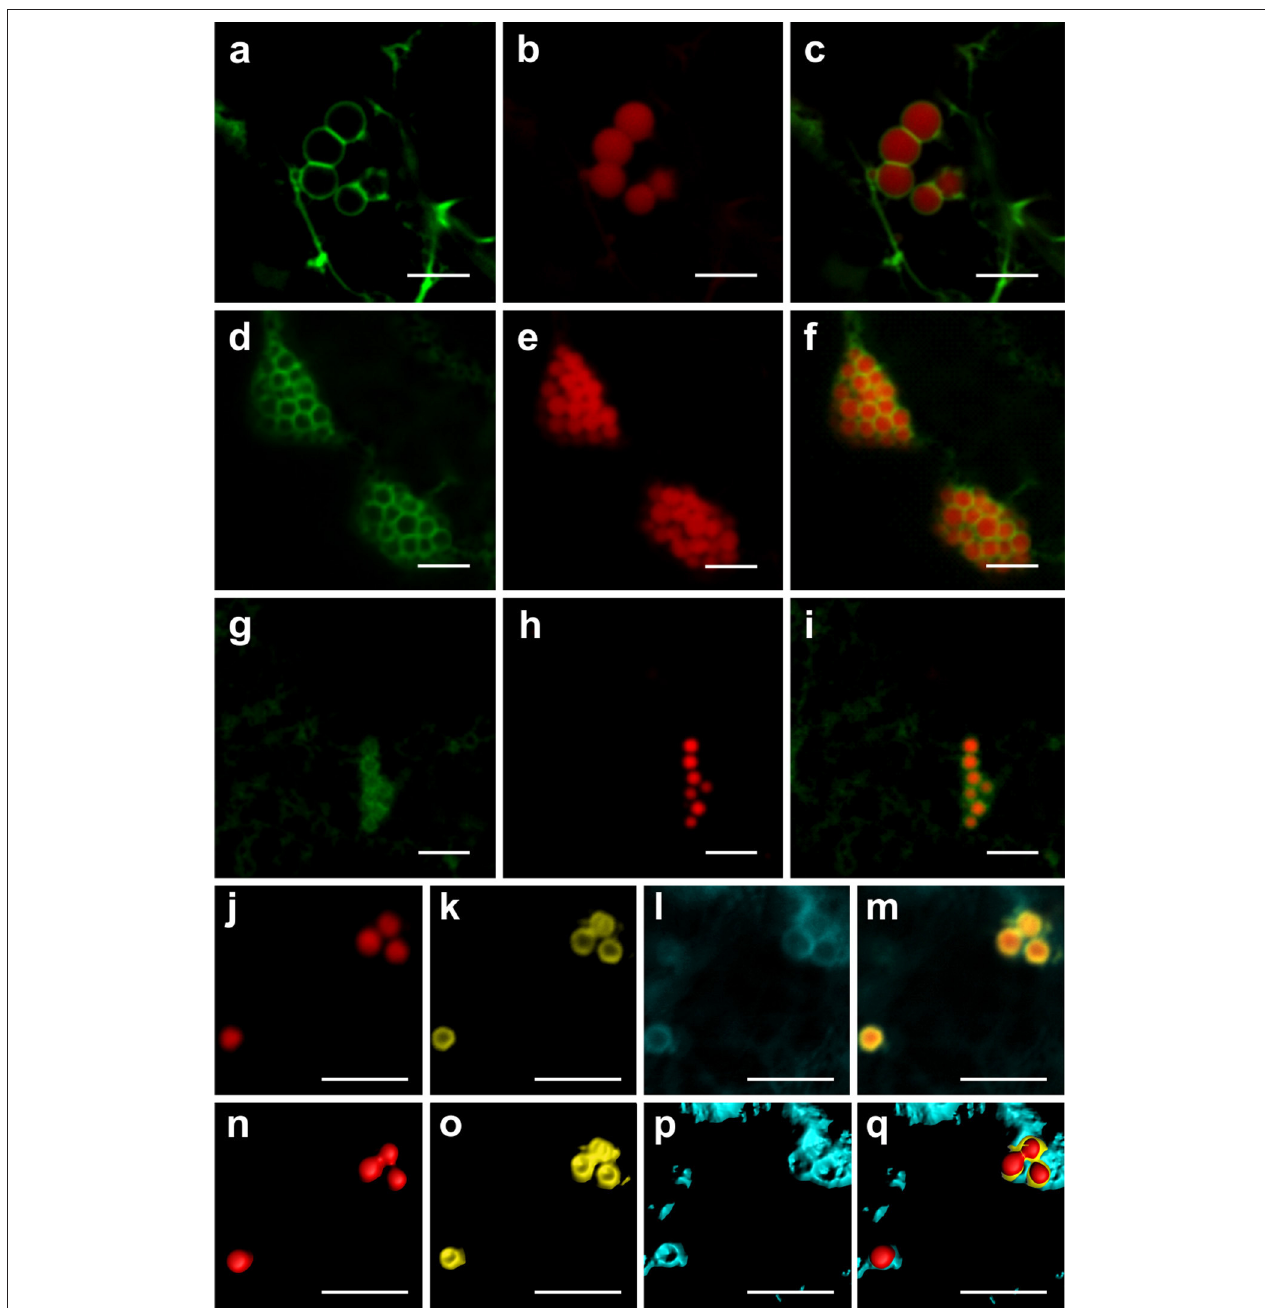
FIGURE 4 | Protein bodies are surrounded by an endoplasmic reticulum-derived membrane. (A–C) Co-expression of GFP-SQS1 and RFP-ELP results in the formation of RFP-ELP PBs surrounded with GFP-SQS1 highlighting the ER membrane. (D–F) Co-expression of RFP-HFBI and GFP-SQS1 results in PBs surrounded by GFP-SQS1. (G–I) Co-expression of Zera-DsRed and GFP-SQS1 results in the formation of Zera-DsRed PBs surrounded by GFP-SQS1. (J–M) Zera-DsRed (J) localizes to the core of PBs and secretory GFP (K) is pushed away from the core to the periphery of PBs. GFP is shown in yellow in this case to allow visualization of the signal. CFP-SQS1 (I) highlights the ER membrane. (M) . Merge image representing the signals from all three channels shows the ER membrane surrounding both GFP and Zera-DsRed. (N–Q) signals from j-m were highlighted in 3D with the Imaris software to allow accurate visualization of each protein. All images were acquired at 4-dpi in sequential mode. Bar, 5 µ